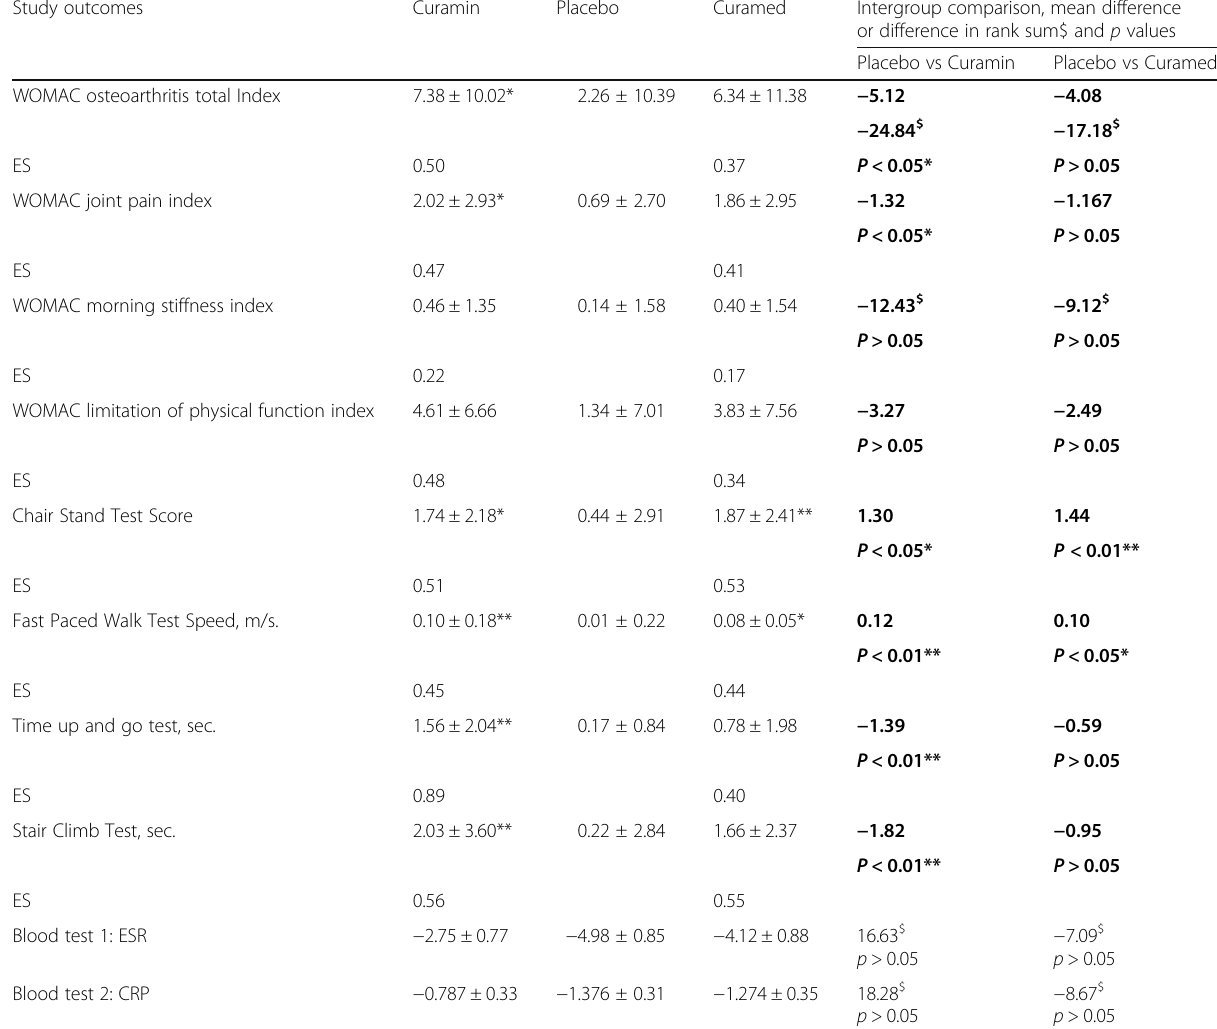
Table 3 Mean change from baseline (week 0) and endpoint (week 12) of primary outcome measures in three groups of patients (mean ± SD), mean difference between groups and effect size (ES, d Cohen , g Hedges ) for mean changes from baseline of groups vs placebo group (95% CI), http://www.psychometrica.de/effect_size.html#anova Study outcomes Curamin Placebo Curamed Intergroup comparison, mean difference